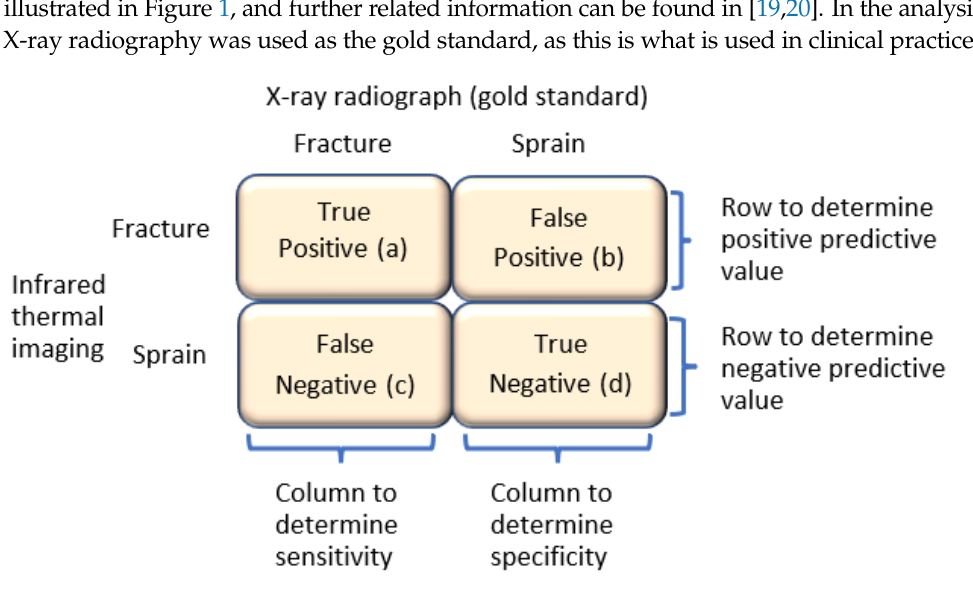
Figure 1. Statistical measures used to analyse effectiveness of MLP and IRTI to differentiate wrist fracture and wrist sprain.